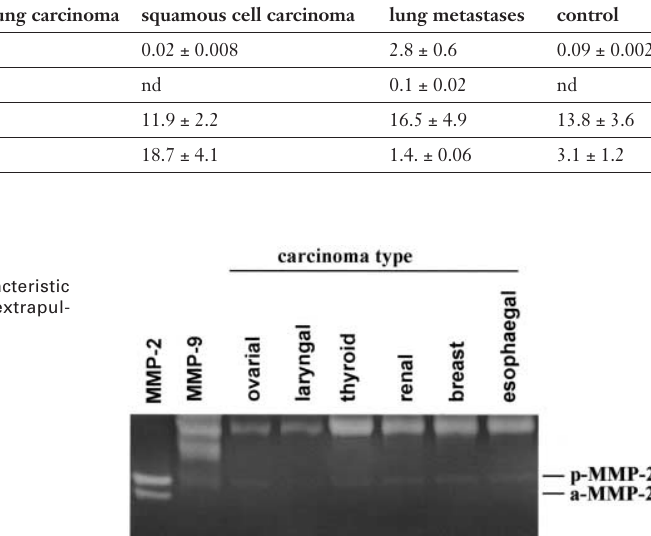
Comparison of MMP activity in tumour-free and tumour- affected lung. “T” indicates tumour-affected site, “N” in- dicates tumour-free lung site, “a” indicates purified human MMP-2, “b” indicates purified human MMP-9. (A) representative zymography for four adenocarcinomas, (B) representative zymography for four small-cell lung carcinomas, and (C) representative zymography for four squamous-cell lung